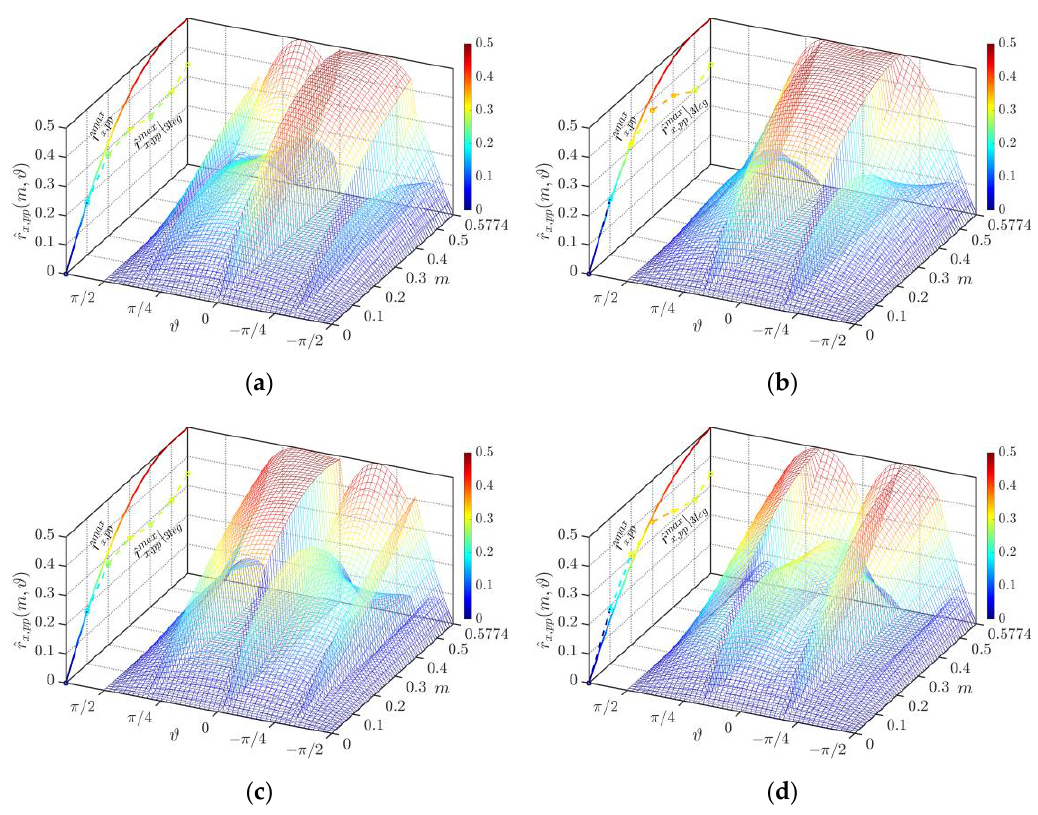
Figure 18. Normalized primary and secondary peak-to-peak phase current ripples in case of: ( a ) DPWM0; ( b ) DPWM1; ( c ) DPWM2; and ( d ) DPWM3.